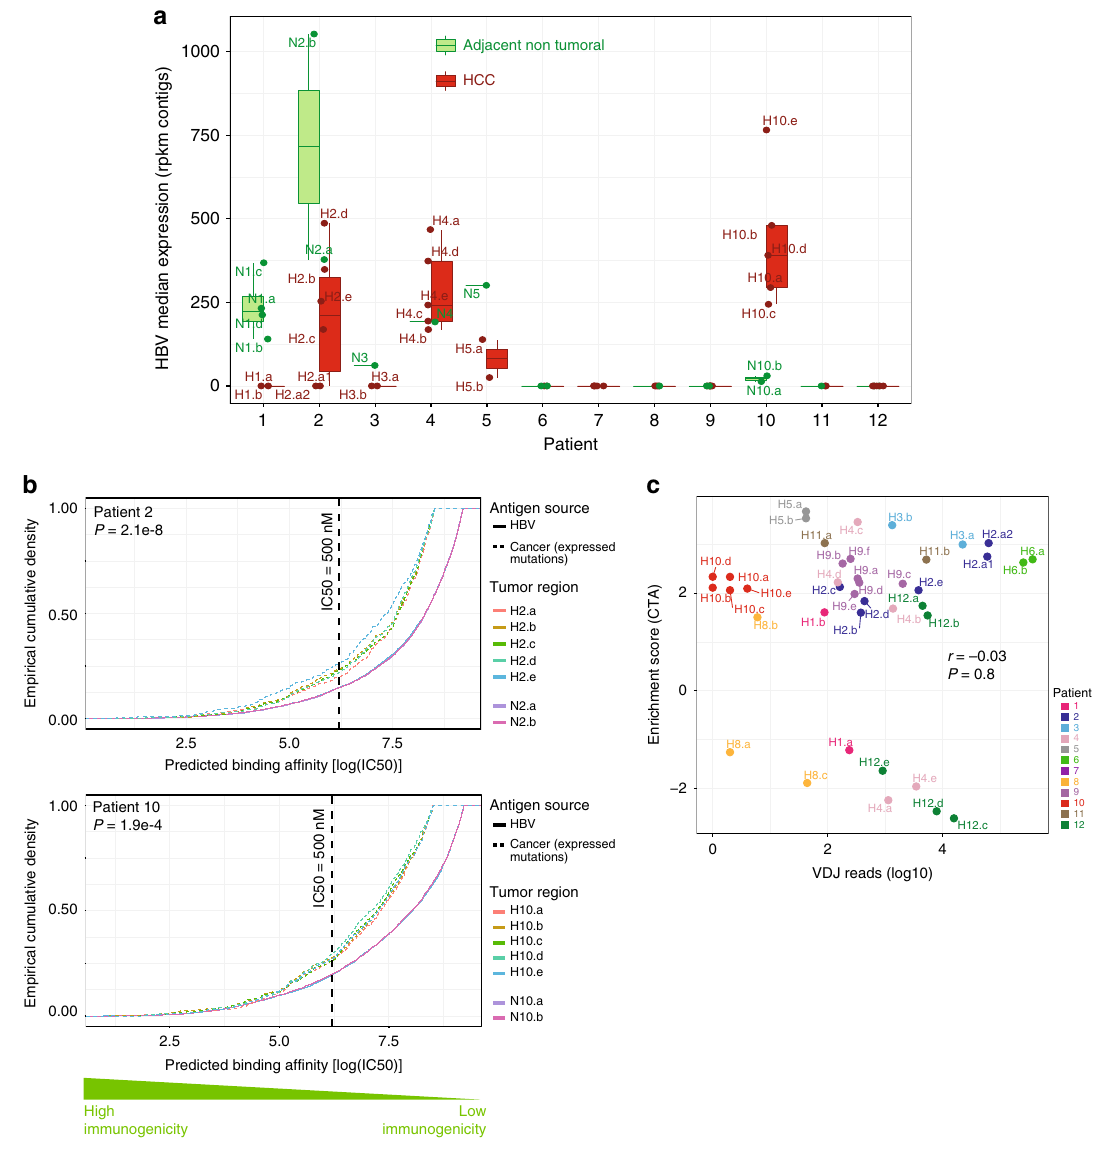
Fig. 4 HBV antigen binding af fi nity and CTA immunogenicity. a Expression distribution of HBV for adjacent nontumoral and tumoral regions across patients (HCC: Red; Adjacent nontumoral: Green, error bars = SE, N = 44 samples. For each boxplot, the centre line represents the median. Upper and lower limits of each box represent the 75th and 25th percentiles, respectively. The whiskers represent the lowest data point still within 1.5× box size of the lower quartile and the highest data point still within 1.5× box size of the upper quartile). b Empirical cumulative density plot of log-scaled binding af fi nity distribution across regions for both HBV and tumor neoepitopes. Kolmogorov-Smirnov test with one-sided alternative hypothesis. p-value is for rejecting the null in favor of the alternative. c Correlation plot of CTA enrichment score and RNA-seq reads mapped to the VDJ locus across regions. Source data are provided as a Source Data fi